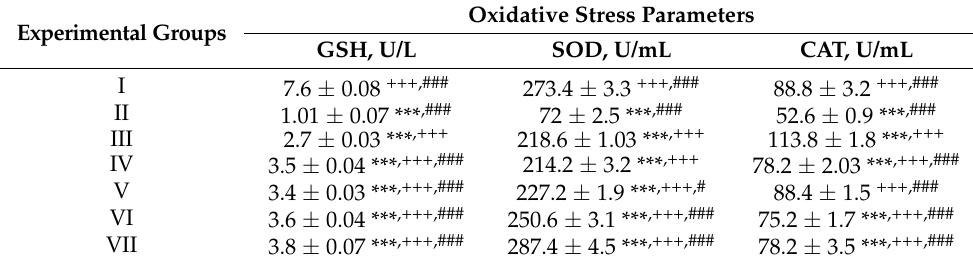
Table 4. Antioxidant enzymes activity in plasma of mice groups. Experimental